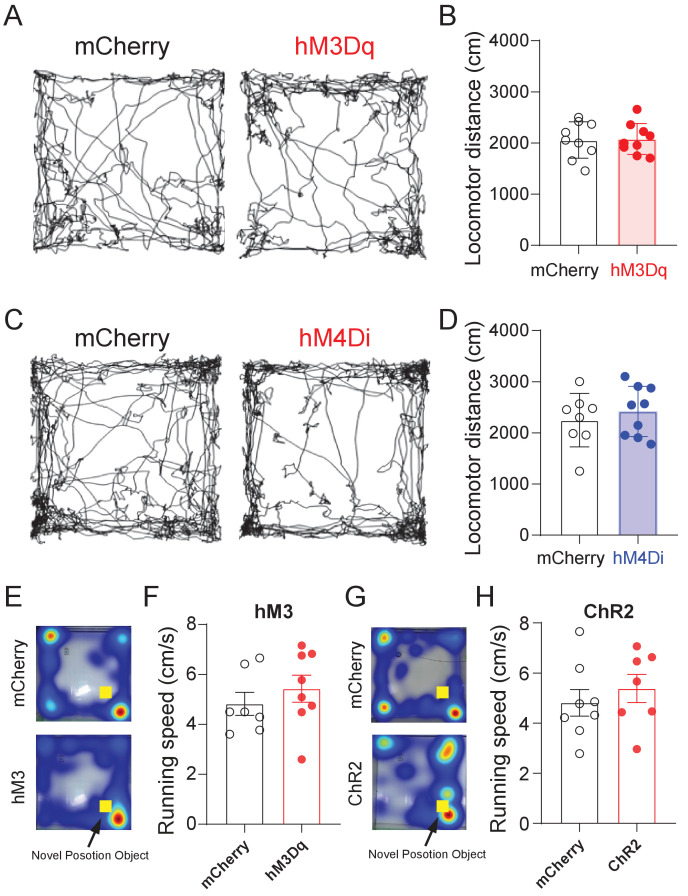
Locomotor activity after activity manipulation of SuMVgat neurons.Locomotor activity in the open field (5 mins, same for both NPR and NOR tests) was recorded 1 hr after CNO administration in mice injected with AAVs expressing mCherry-, hM3Dq- or hM4Di. (A-B) Typical locomotor traces (A) of mCherry- or hM3Dq- mice after CNO injection, and locomotor activity was not changed (B), compared to mCherry control mice (unpaired t-test, t16 = 0.1325, p=0.8963). (C-D) Typical locomotor traces (C) of mCherry- or hM4Di- mice after CNO injection, showed locomotor activity was not changed (D), compared to mCherry control mice (unpaired t-test, t16 = 0.2374, p = 0.8177). (E, G) Heatmap of representative locomotor traces in the NPR test during chemogenetic activation of SuM neurons (E) or optogenetic activation of SuM-DG projections (G), respectively. (F, H) The average running speed during the NPR test during chemogenetic activation of SuM neurons (F) or optogenetic activation of SuM-DG projections (H), respectively. p > 0.05 by unpaired t-test.